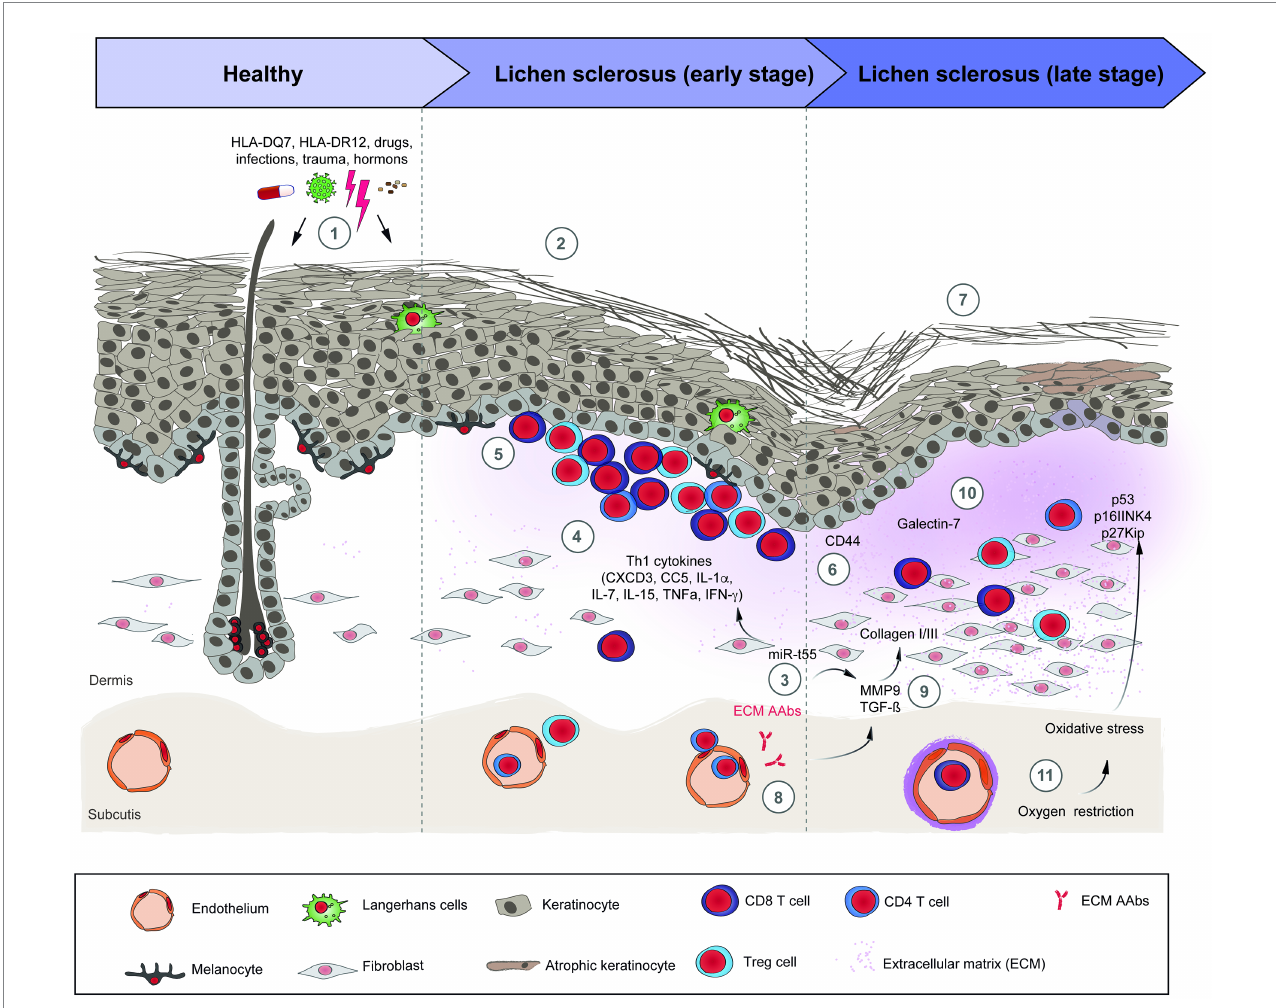
FIGURE 1 Schematic overview of lichen sclerosus pathogenesis. (1) Risk factors for LS; (2) The inflammatory early stage of LS is unspecific and shows a dermoepidermal interface band of mostly T-cells. (3) miR-155 is overexpressed in LS, stimulates the Th1 profile and the dermal sclerosis. (4) Th1 cytokines implicated in the pathogenesis of LS. (5) Lichenoid infiltrate of TCD4+, TCD8+, and Tregs cells in the upper dermis. (6) Abnormal expression of CD44 in the epidermis and lichenoid infiltrate. (7) The sclerotic late stage of LS presents an atrophic epidermis, with comedo-like plugs and a cleft in the stratum corneum, dermal sclerosis, reduction and dilation of dermal vessels and the appendages disappear. (8) The autoantibodies against EMC1 may activate MMP9, which subsequently activates TGF- β . (9) TGF- β and BMP2 induce the synthesis of collagen I and III in fibroblasts. (10) Galectin-7 induces the synthesis of collagen I and III. (11) Along with inflammation, the vessel sclerosis contributes to the oxidative stress in LS, leading to downregulation of tumor suppressors genes and overexpression of p53 in the skin, factors related with the development of skin carcinomas. The precise sequence of events and their interactions are only incompletely understood. References: BMP2: bone morphogenetic protein 2; EMC1: extracellular matrix protein 1; LS: lichen sclerosus; MMP9: metalloproteinase 9; TGF- β : tumor growth factor beta. TNF- α : Tumor necrosis factor